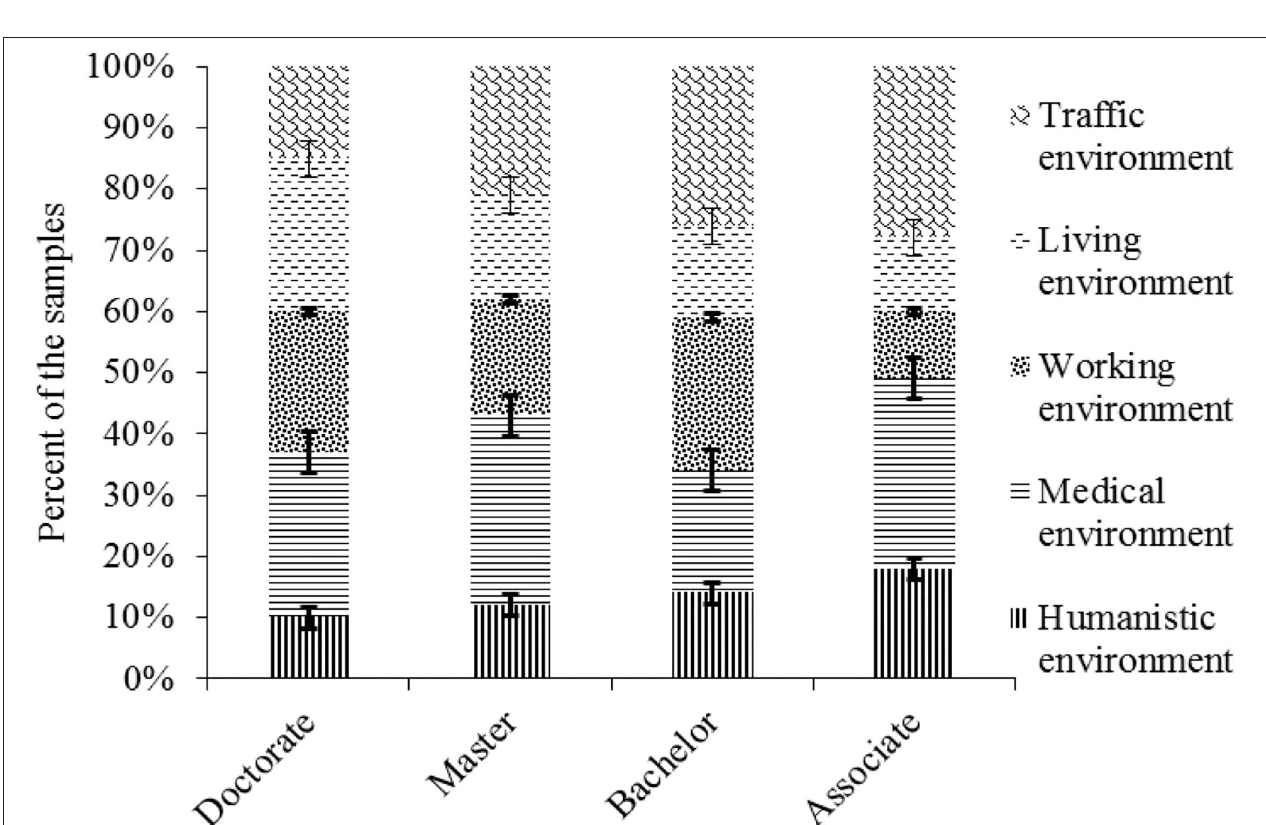
FIGURE 4 | Respondents’ partial selection bias toward